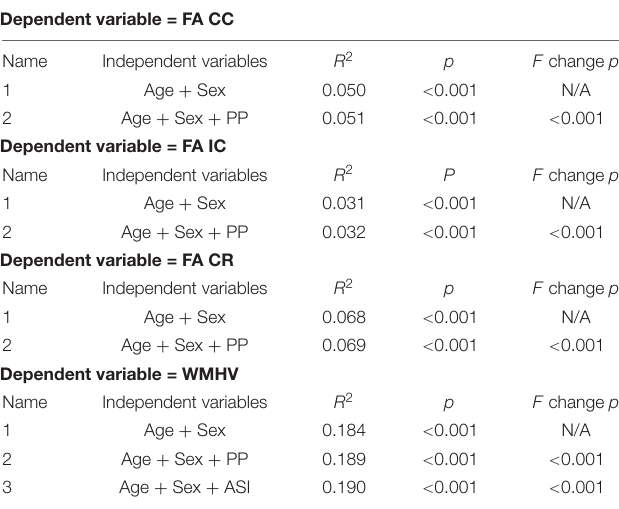
Two cardiovascular risk factors were fed to each stepwise linear model: PP and ASI. These models aimed to find which cardiovascular risk factors among PP and ASI best predict the fractional anisotropy (FA) of the corpus callosum (CC), internal capsule (CI), corona radiata (CR) and the white matter hyperintensity volume (WMHV). Fixed covariates were age and sex. R 2 of the significant models are reported as well as the overall p-value of the model and the significant F changes when comparing with previous model.